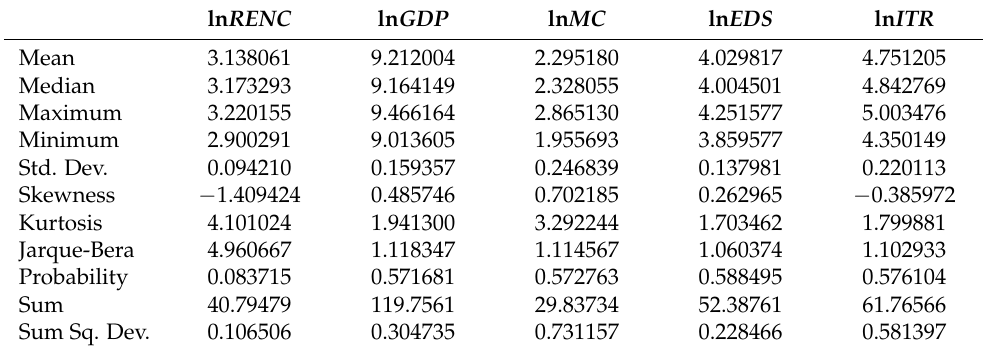
Table 2. Descriptive statistics of the variables.